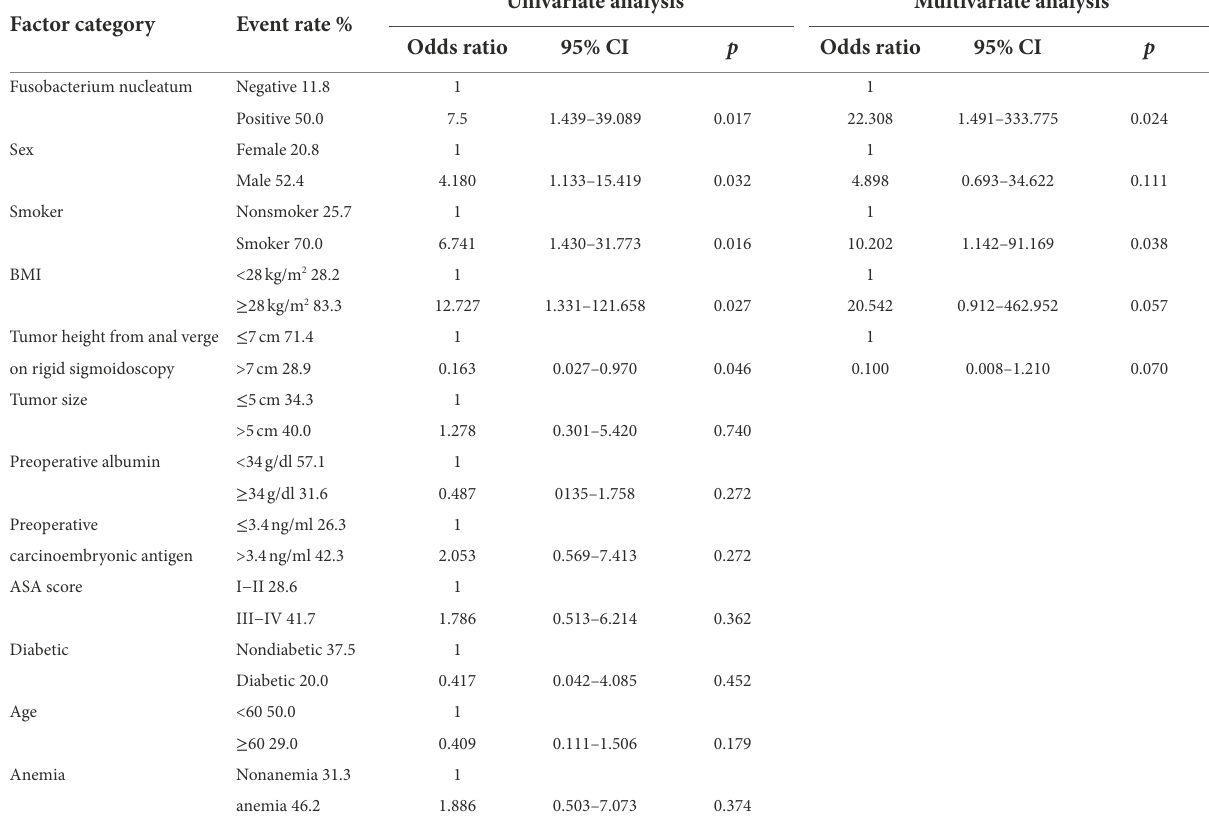
TABLE 1 Univariate and multivariate analyses of risk factors for AL.